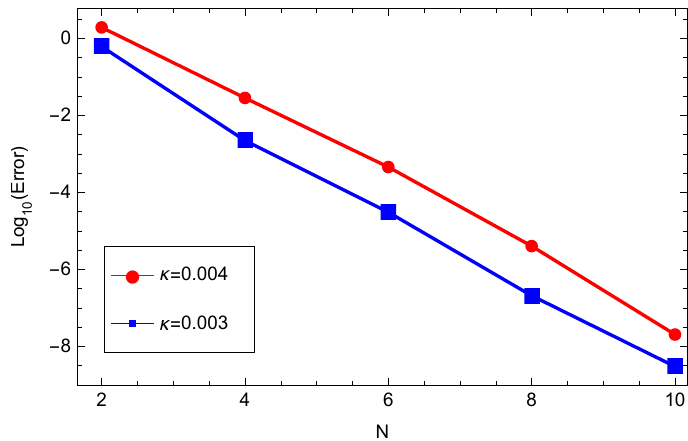
Figure 7. Log-errors of Example 3 for different values of ν and N